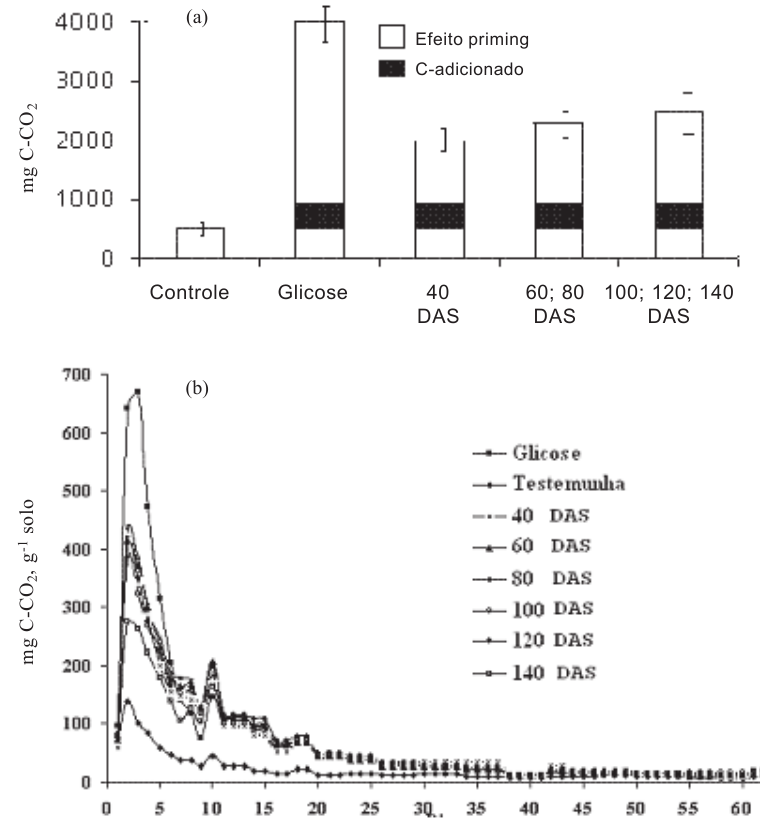
Figura 1. Acúmulo de CO durante todo o período de incubação (a) e evolução diária de CO 2 amostras sem adição de C (controle) e com adição de glicose e de raízes de arroz aos 40, 60, 80, 100, 120 e 140 dias da semeadura